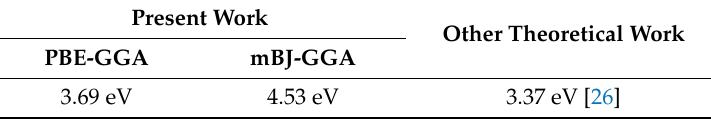
Table 2. Calculated energy band gap E g (eV) of SrZrO 3 compound.